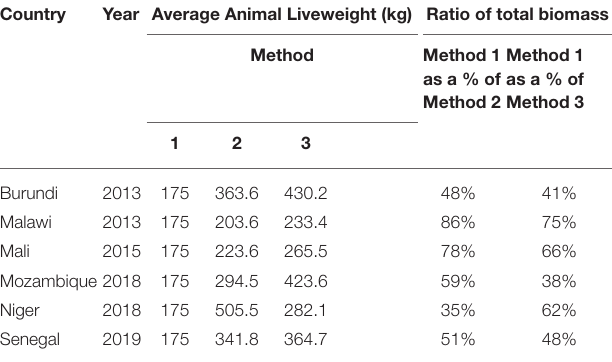
TABLE 4 | Comparison of biomass estimation methodologies.